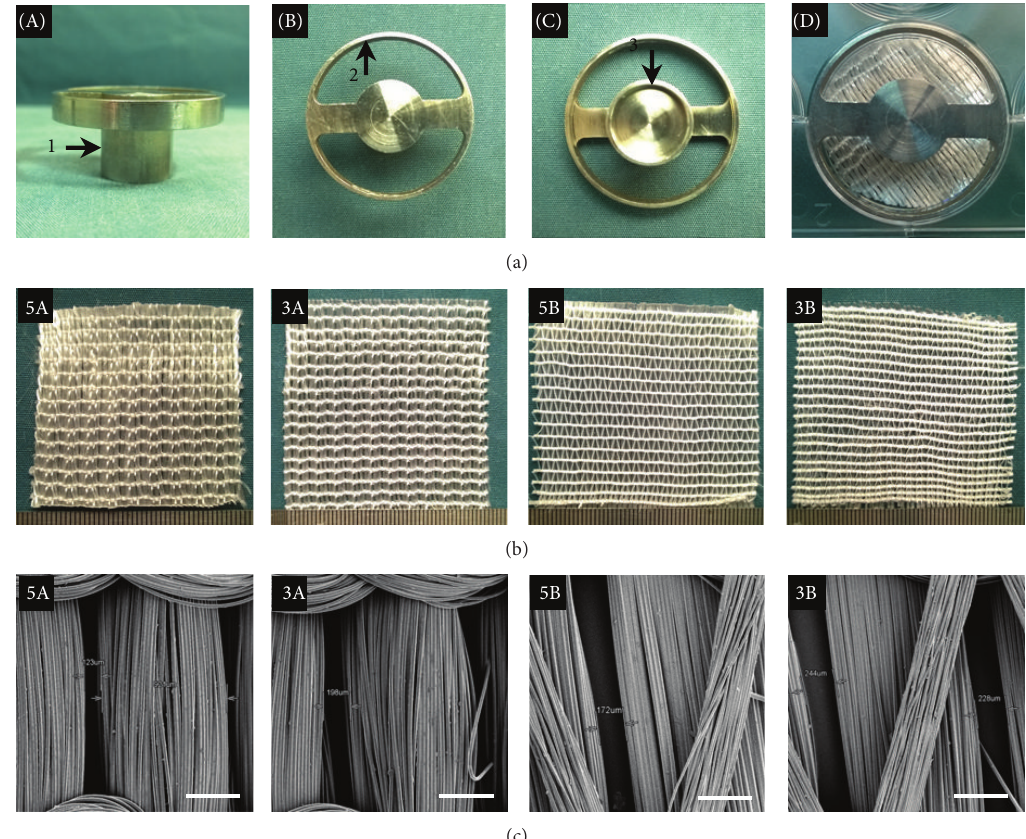
Figure 1: Gross view of the cell migration model (a-A, a-B, and a-C) and cell migration model with sheets (a-D). The gross view and SEM images of surface morphology of four kinds of PET-ALs (b and c). 5A: the linear density is 5000 D and the knitting method is full-set threading warp knitting; “5000 D” indicates 5000 grams weight of the 9000 meters PET fiber bundles under convention moisture regain; 3A: the linear density is 3000 D and the knitting method is full-set threading warp knitting; 5B: the linear density is 5000 D and the knitting method is part-set threading warp knitting; 3B: the linear density is 3000 D and the knitting method is part-set threading warp knitting; 1 indicates central cylinder (side); 2 indicates annular ring; 3 indicates central cylinder (underside). Scale bars: 500 𝜇